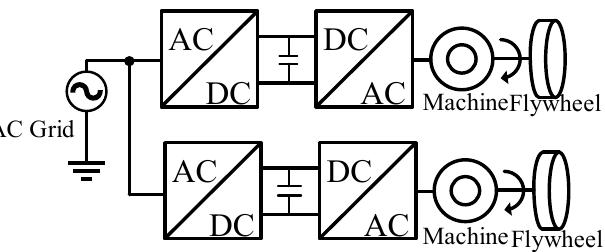
Figure 29. Schematic diagram of the AC bus integration system with flywheel.